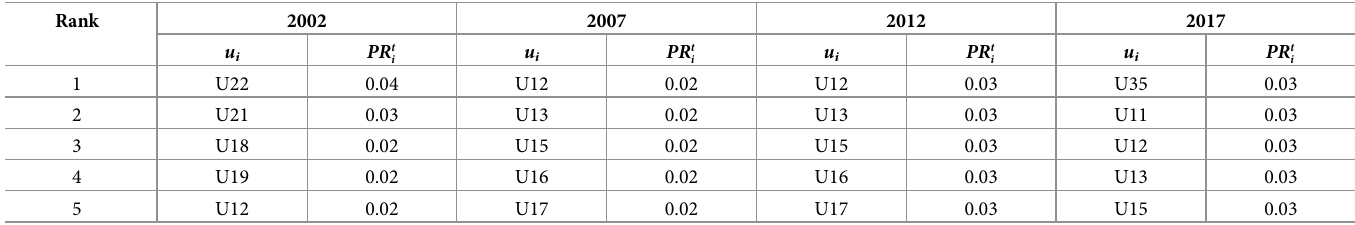
Table 4. Top 5 industries with